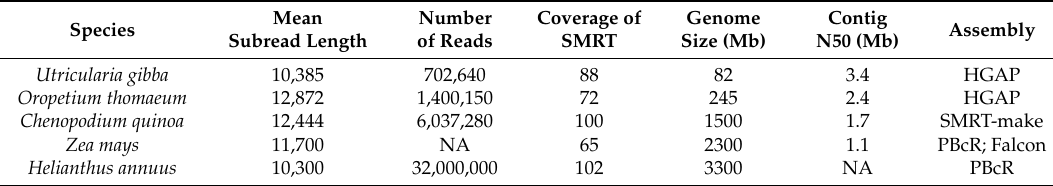
Table 2. Examples of genome sequencing and assembly by long